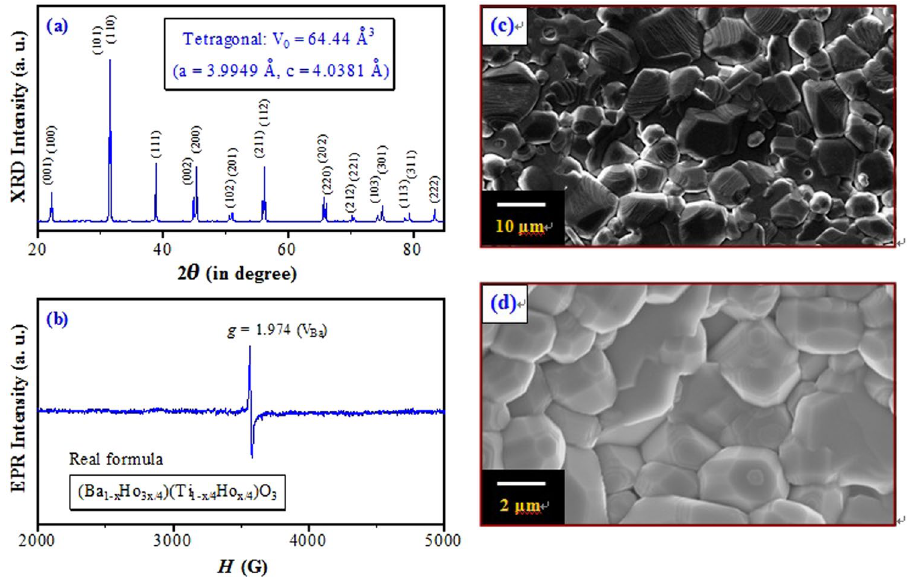
Figure 1. ( a ) XRD pattern, ( b ) EPR spectrum, SEM images on ( c ) the surface and ( d ) the interior for the nominal (Ba 1 − x Ho x )Ti 1 − x /4 O 3 ( x = 0.01) ceramic (BHTH) sintered at a sintering temperature of T s = 1400 °C. The real formula of BHTH is expressed by (Ba 1 − x Ho 3 x /4 )(Ti 1 − x /4 Ho x /4 )O 3 with Ba vacancies (V Ba